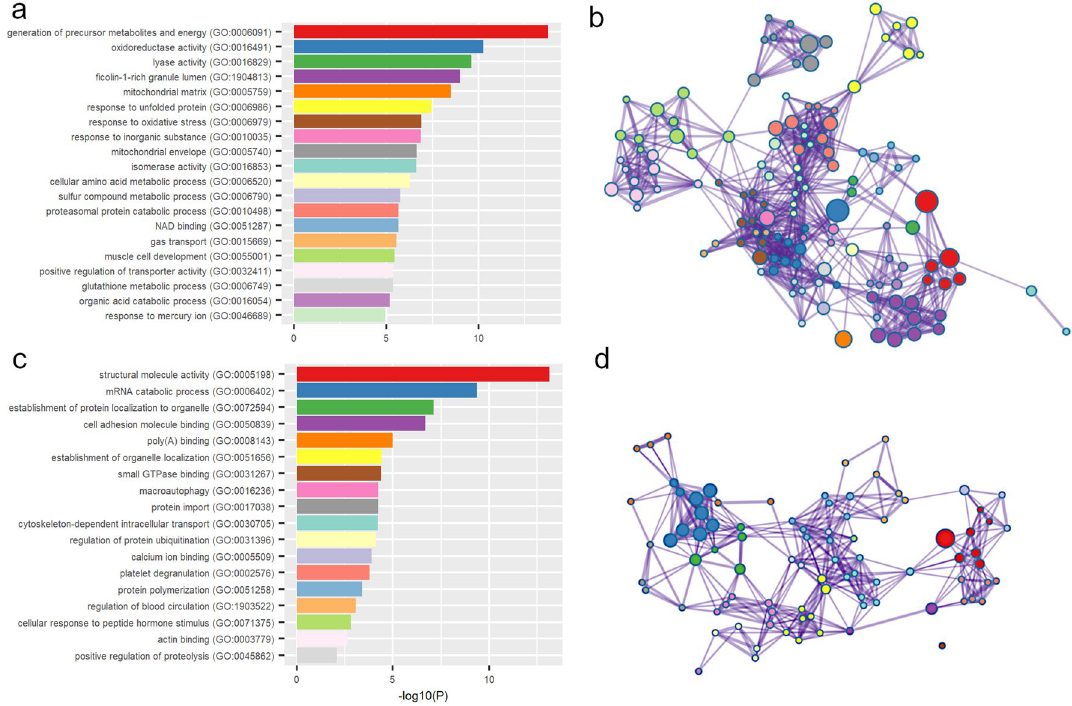
Figure 7. Summary of Enrichment Analysis. ( a ) The most significant enrichment term within each of the 20 most significant Metascape defined clusters, each defined by the smallest respective p-values, for the positive group. ( b ) Network illustrating relatedness of individual enrichment terms, wherein individual nodes represent enrichment terms and nodes of the same color belong to the same Metascape defined cluster. ( c,d ) The same is shown for the 18 Metascape defined clusters from the negative group. Network maps were derived through modification of data provided by Metascape with the Cytoscape